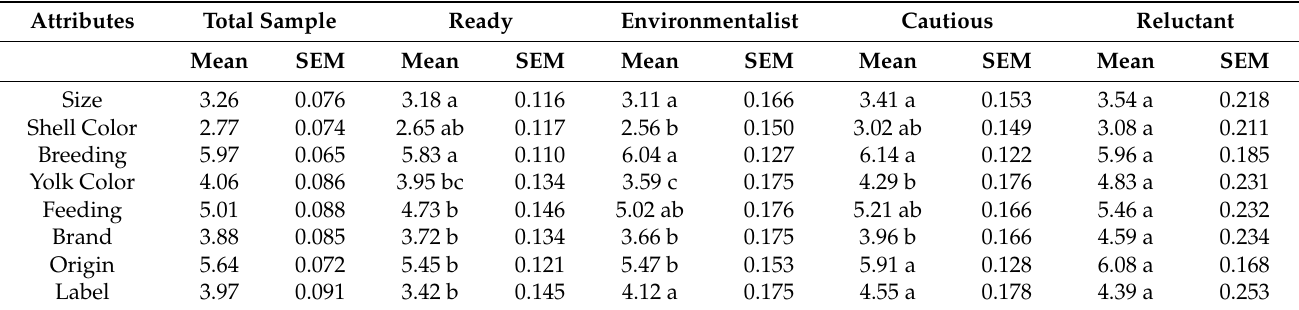
Table 7. Importance of egg attributes for total population and consumer clusters.